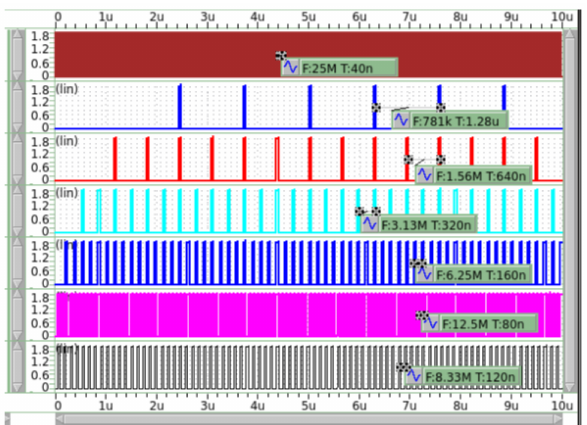
Figure 12. Multi-modulus divider simulation (781 kHz–33